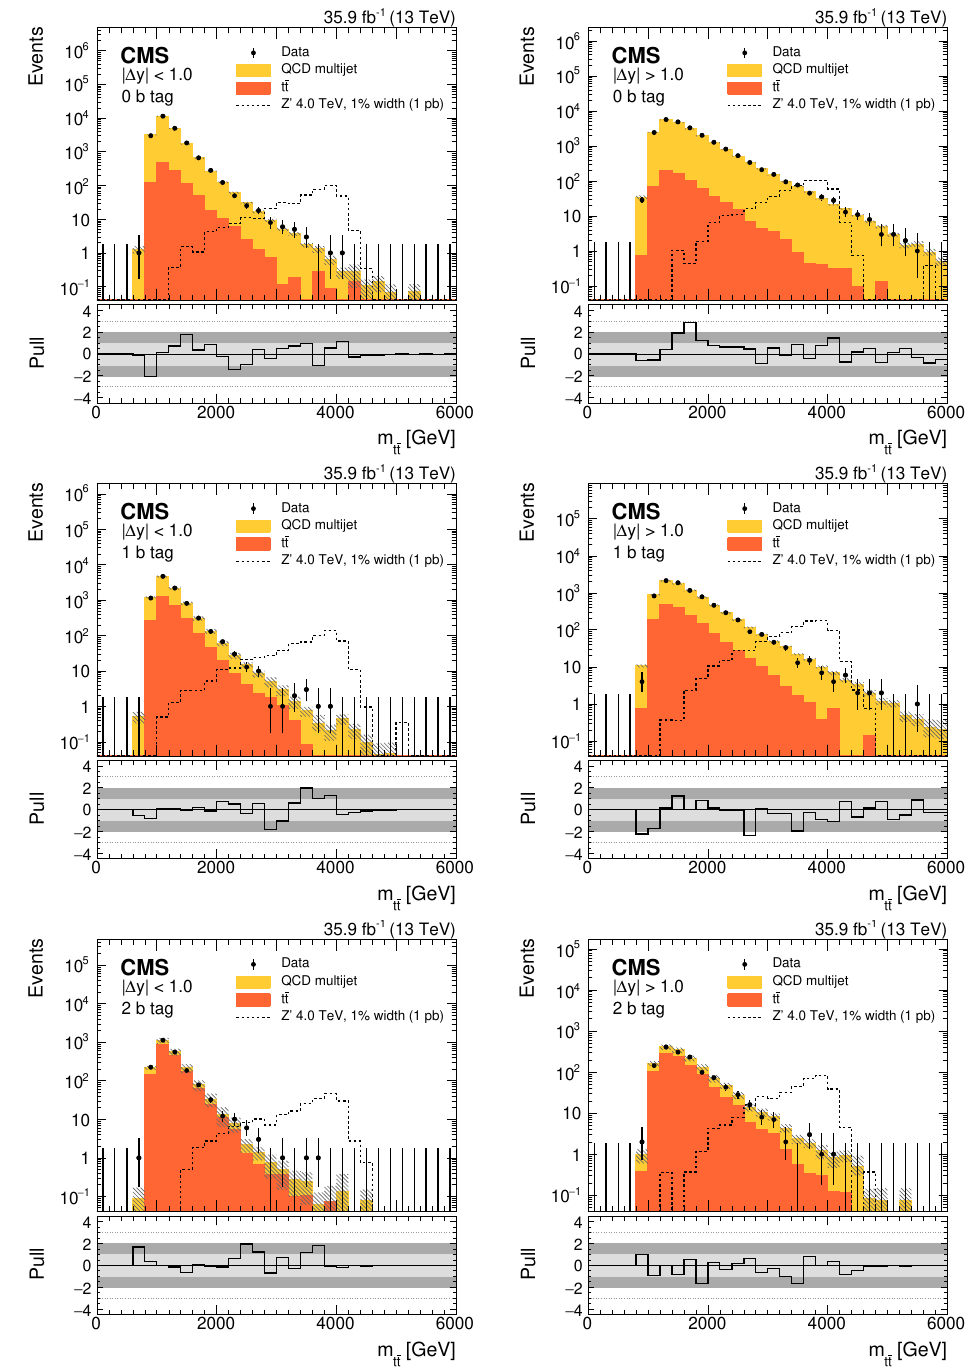
Figure 11 . Distributions of m for the fully hadronic channel SR categories, used to extract the tt (cid:12)nal results. The contribution expected from a 4 TeV Z 0 boson, with a relative width of 1%, is shown normalized to a cross section of 1 pb. The hatched band on the simulation represents the uncertainty in the background prediction. The lower panel in each plot shows the pull of each histogram bin from the SM prediction. The light (dark) gray band represents a pull of one (two) s.d. from the predicted value.